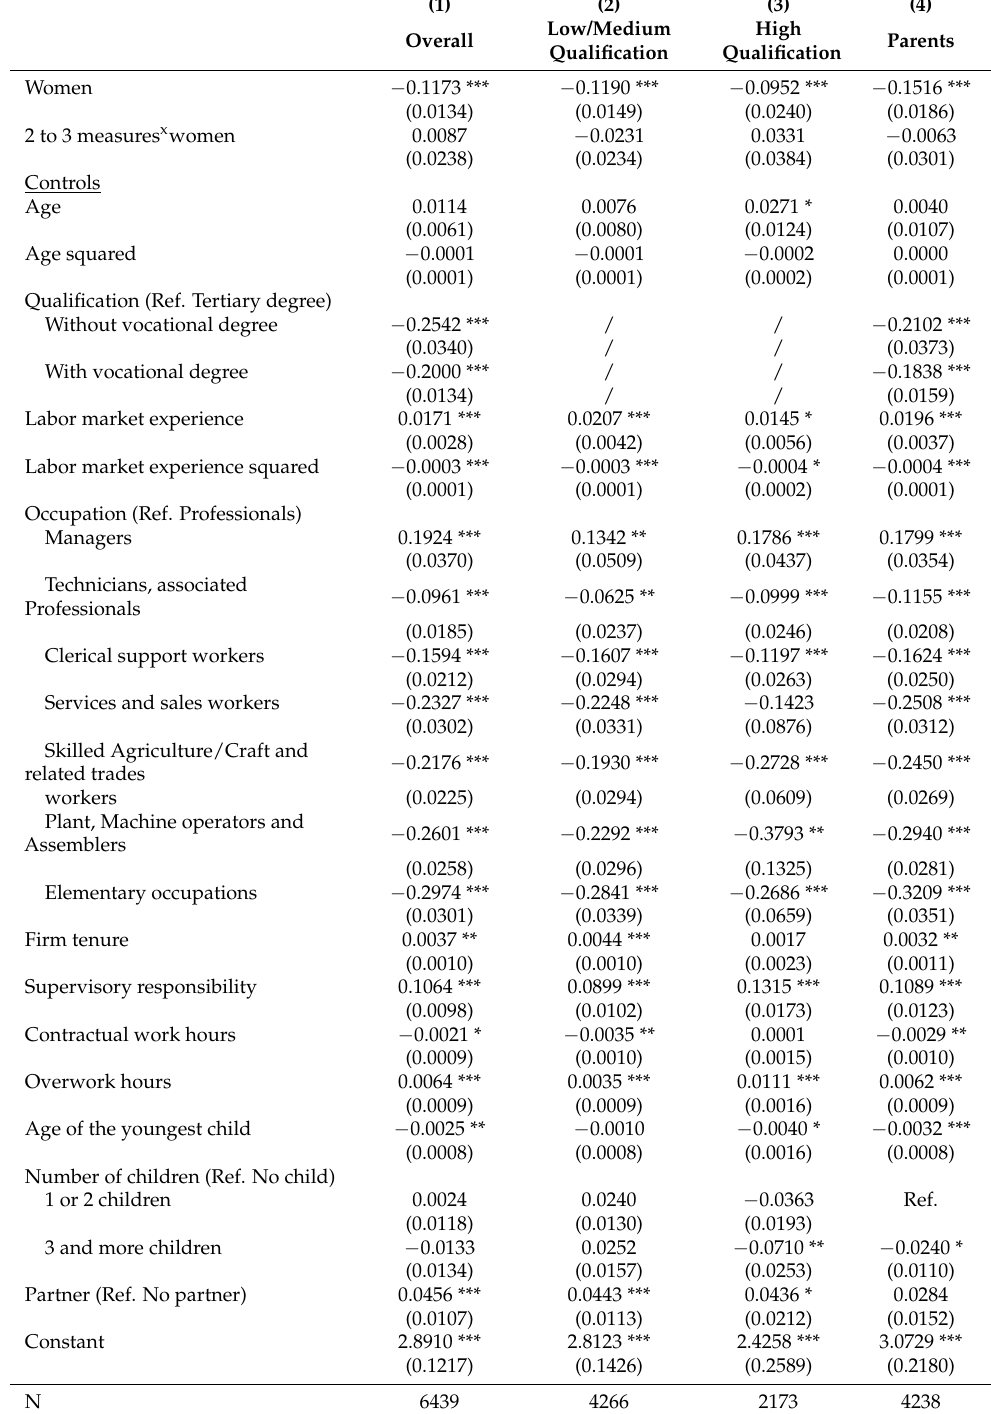
Table A6. The association of multiple EQM and log hourly wages including control variables (extended version of Table 4, step